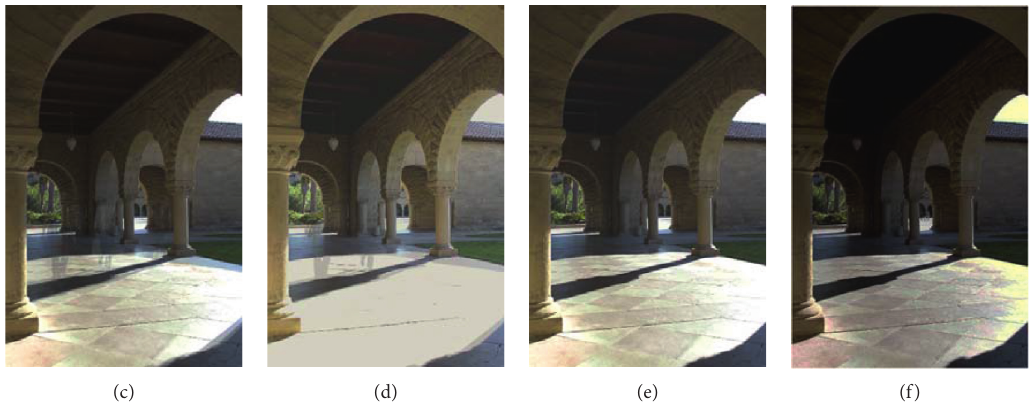
Figure 7: Multiple-exposure image sequences Arch fusing result. (a) Multiple-exposure image sequence Arch. (b) Arch after compressive sensed and reconstructed (c) Reference [2]. (d) RPCA. (e) PSSV. (f) OURS.